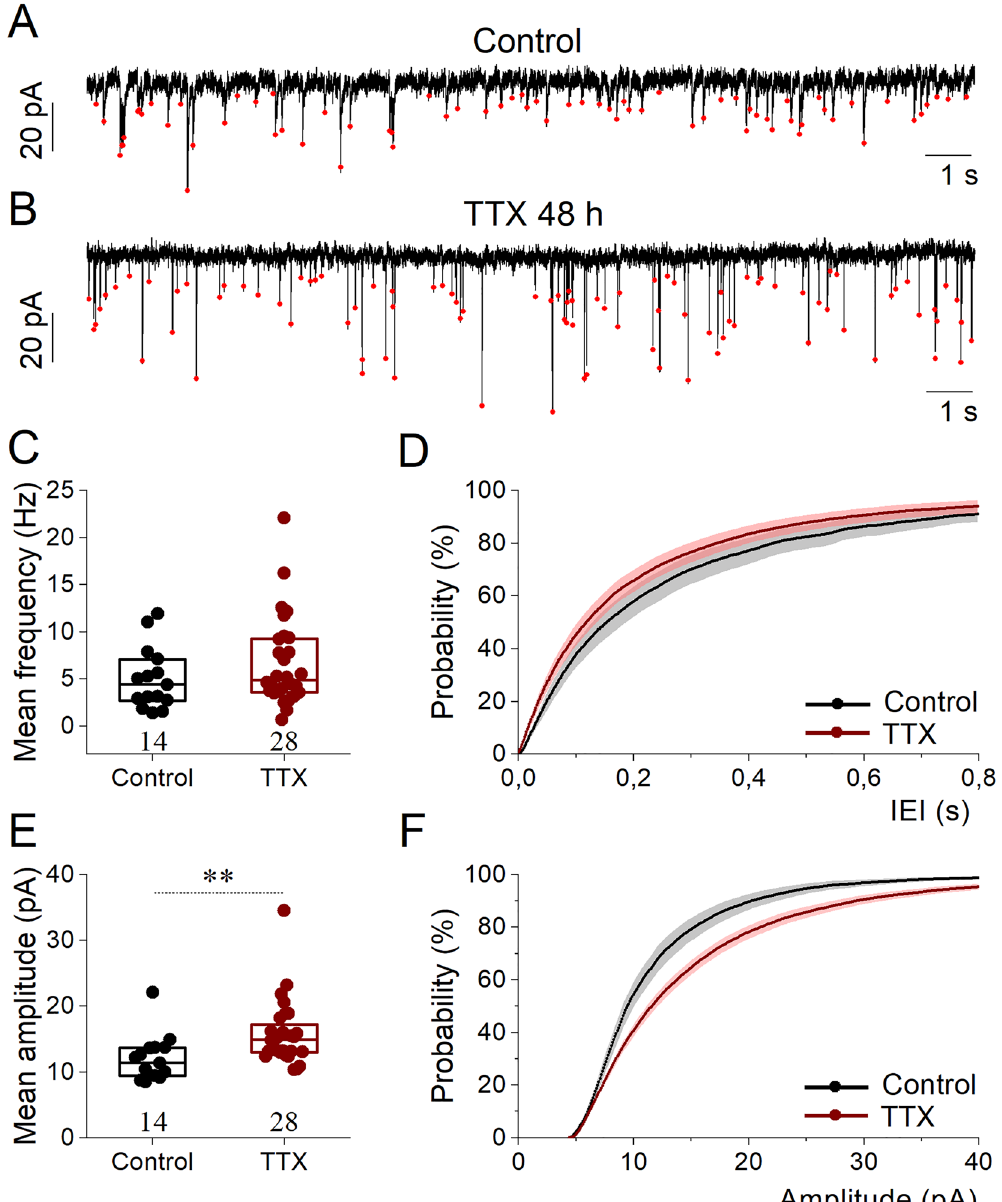
Figure 2. The amplitude of spontaneous excitatory postsynaptic currents is increased by 48 h silencing of cultured hippocampal neurons. Representative voltage clamp recordings of miniature excitatory postsynaptic currents (mEPSCs) of 20 s duration are shown in ( A,B ) from control vs. TTX-treated neurons, respectively. Mean mEPSC frequency data from control and TTX-treated neurons are compared in ( C ). Pooled cumulative probability distributions of inter-event intervals are shown in ( D ). Mean mEPSC amplitudes are compared in ( E ). Cumulative amplitude probability histograms for the two conditions are shown in ( F ). Data are representative of two (control) and four (TTX) independent cultures. Box plots indicate medians and 25–75% range of data. Number of recorded cells is indicated on the graphs. Values are expressed as mean ± SEM (**p < 0.01; Mann–Whitney U